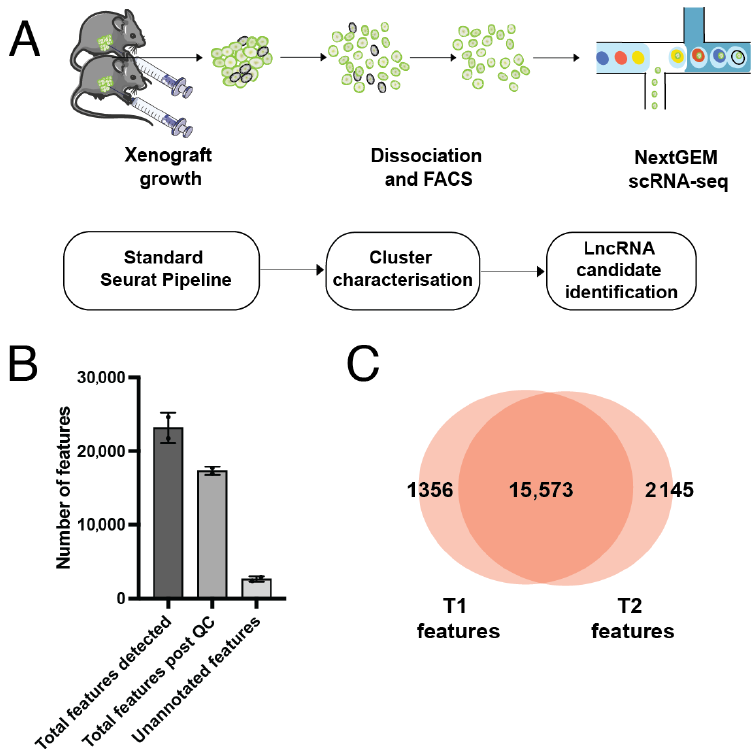
Figure 1. Growth and sequencing of cell-line derived xenografts. ( A ) Outline of methods used. Xenografts were grown in vivo, FACS sorted for GFP+ cells and single cell sequenced using 10 × technology. Data was analysed in R using the Seurat package, and clusters were further characterised and investigated for lncRNA expression. ( B ) Feature detection pre and post QC. A low number of unannotated features were also detected. Error bars indicate the mean of two biological replicates ± stdev. ( C ) Overlap of detected features between the two samples. T1 = Tumour 1, T2 = Tumour